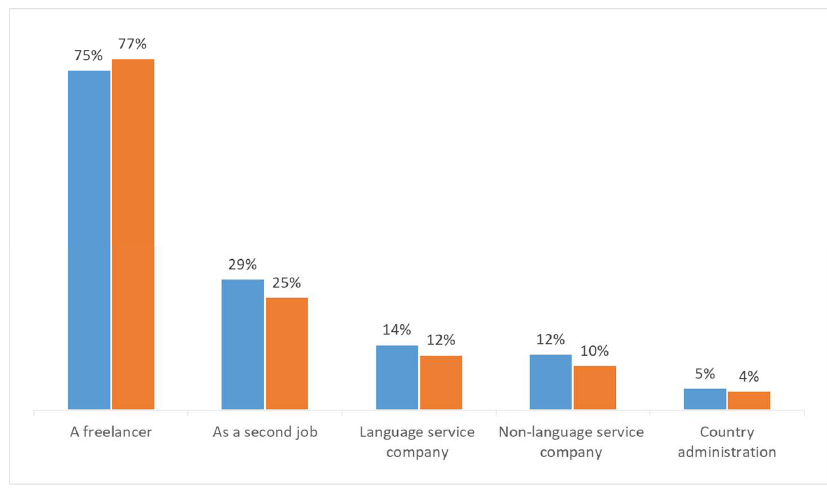
Figure 6. Usage of offline/online tools for translation according to employment type. N = 98.